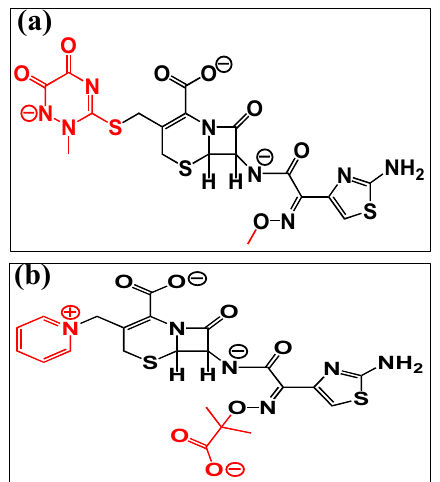
Figure 1. Structures of anionic ( a ) Cefx and ( b ) Cefz drugs in 0.1 M NaOH